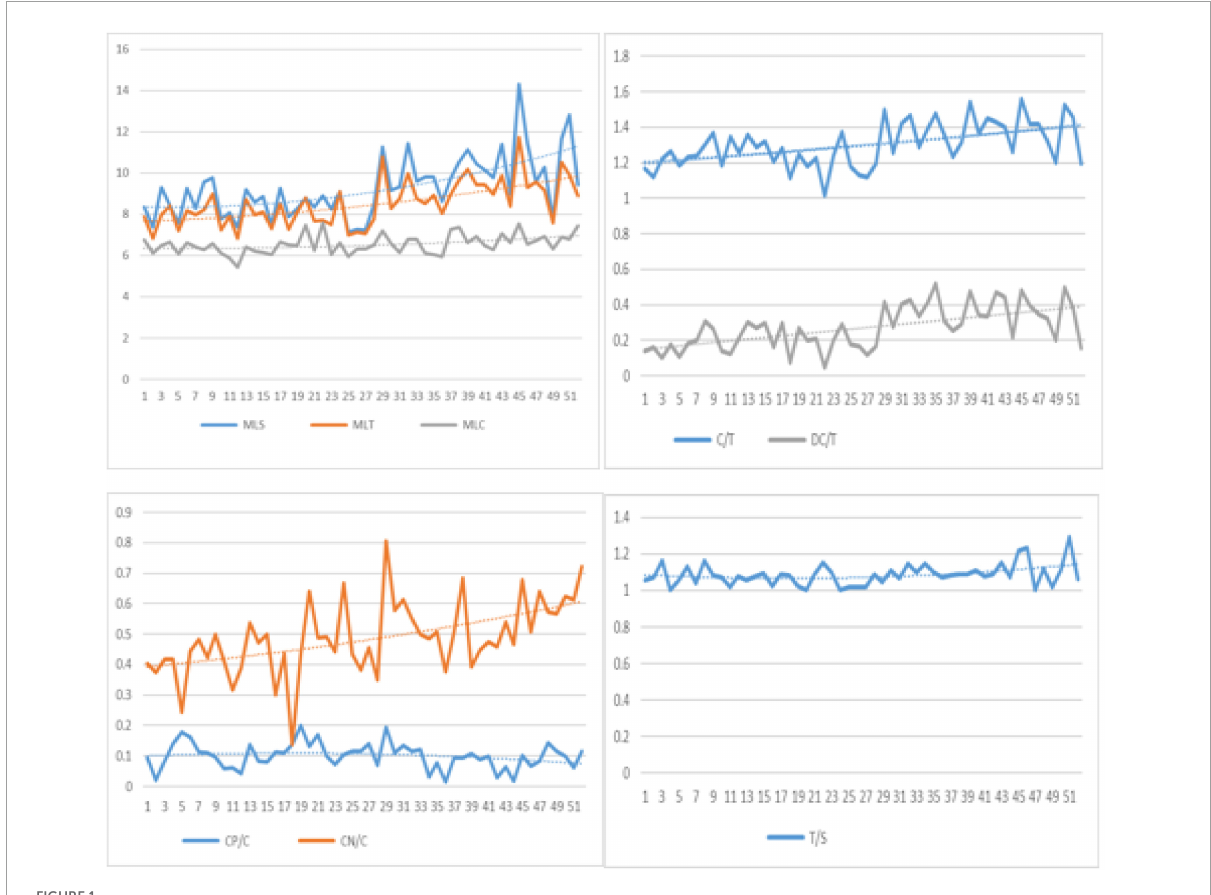
FIGURE1 The development of eight large-grained measures over